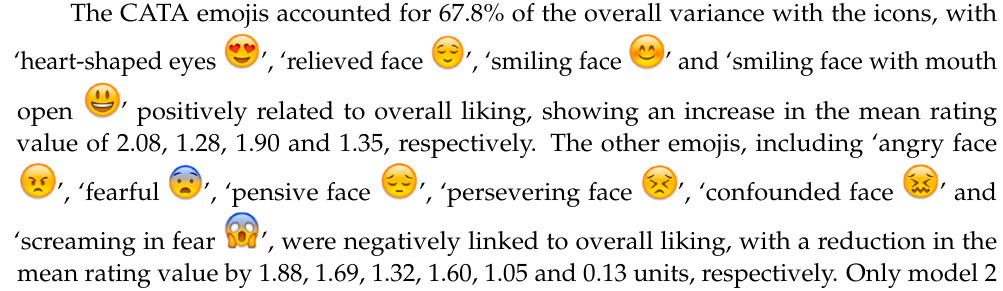
** Indicates significant differences between samples according to Cochran’s Q test at p < 0.001. * Indicates significant differences between samples according to Cochran’s Q test at p < 0.05. ns Indicates no significant difference between samples according to Cochran’s Q test at p > 0.05, with ‘a’ the largest in case of Western and ‘x’ in case of Asian consumers. Signifi ‐ cant differences between pairs of samples according to Fisher’s exact test are indicated by bold terms. Fisher’s exact test is generally more conservative than Cochran’s Q test, so the paired comparisons may all be not significant even if the overall test is significant.